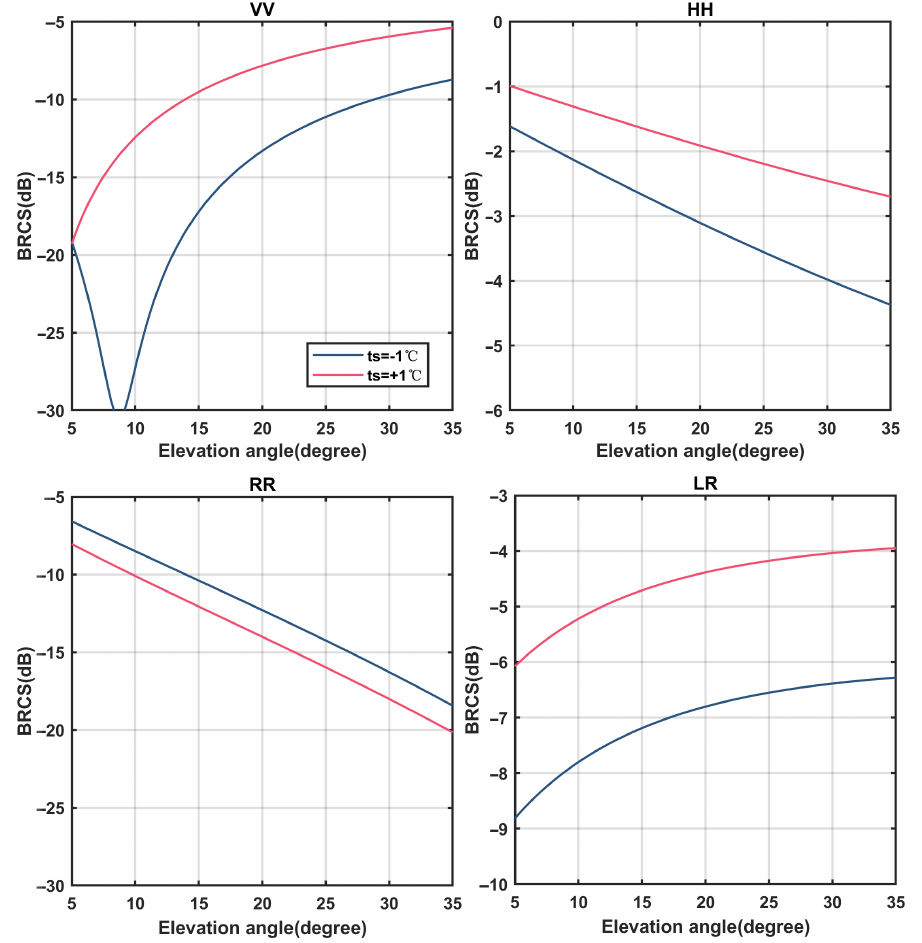
Figure 4. Variation of BRCS with elevation angle at different